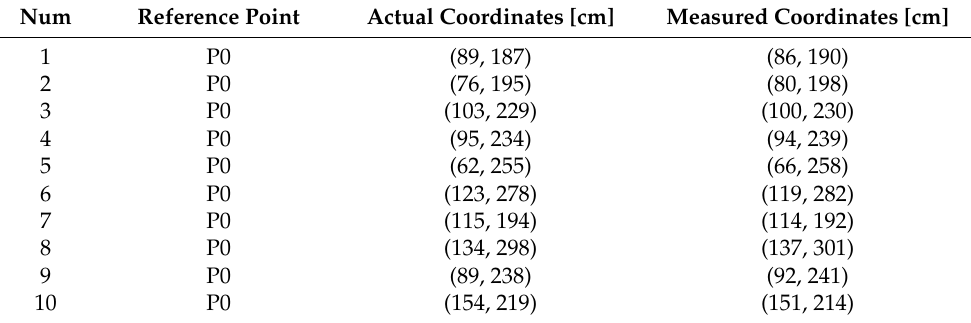
Table 5. Range data of reference